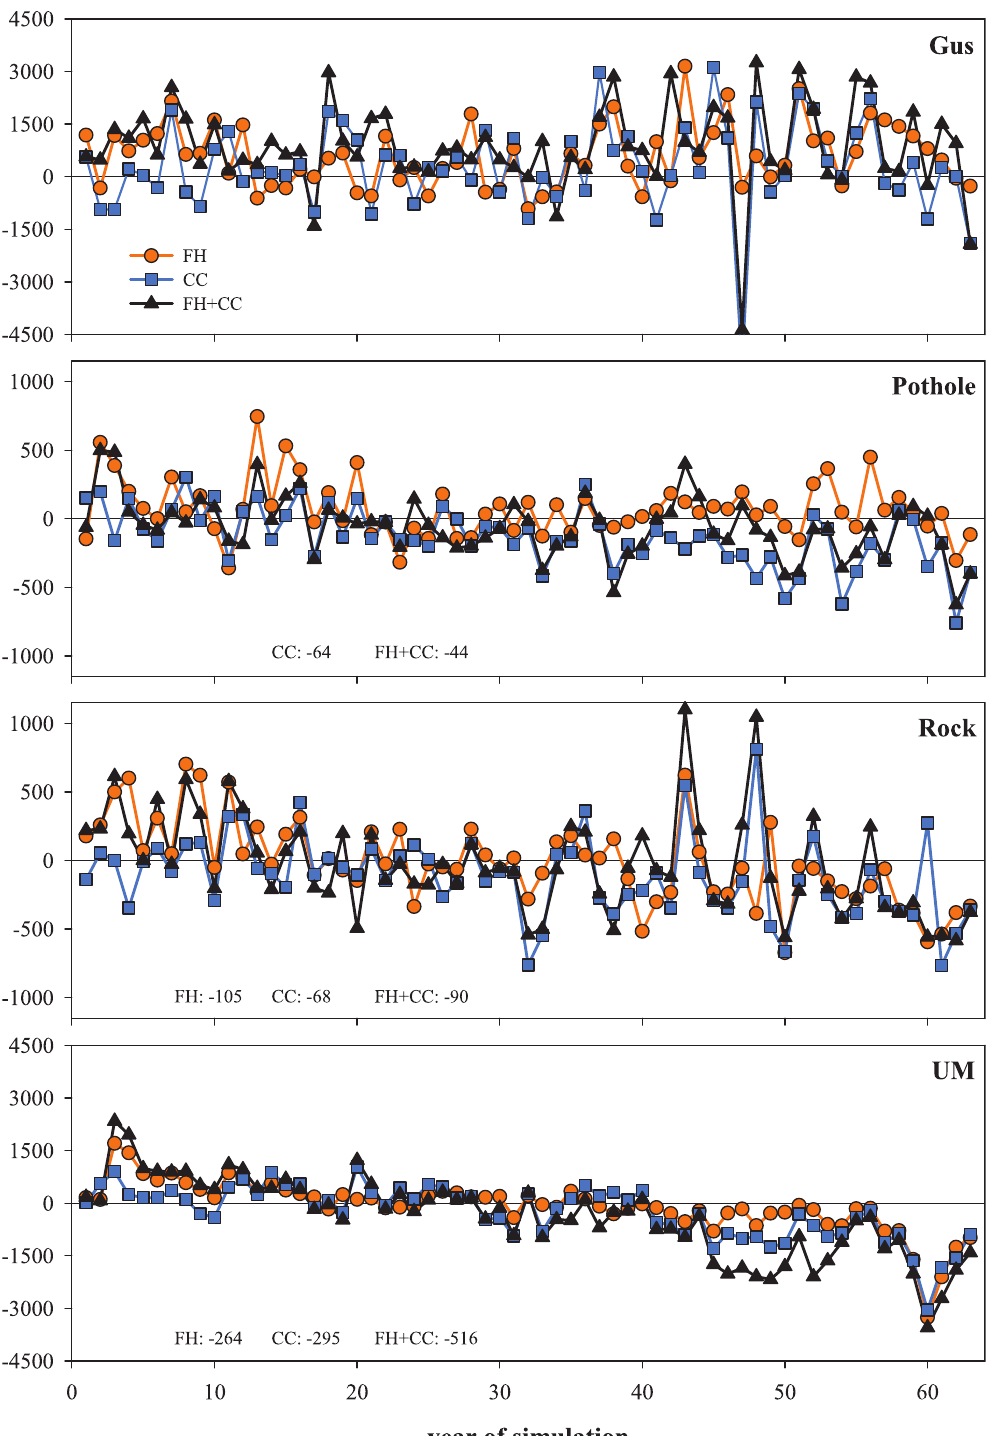
Fig 2. Differences in Total Summer Biomass of Trout between Scenarios and Baseline. Difference in mean total summer biomass (g) from the five replicated simulations over time for each scenario of forest harvest (FH), climate change (CC), and their combined effects (FH+CC) compared to baseline, in Gus Creek, Pothole Creek, Rock Creek, and Upper Mainstem (UM). Scenarios include manipulations of stream temperature and flow regimes (see methods narrative for detail). Only significant trends (P < 0.05) for the entire study period have been numerically shown with the slope of the trend (g/decade).